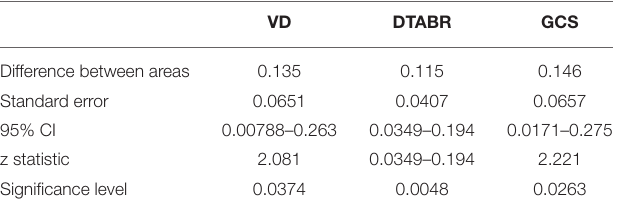
TABLE 3 | Pairwise comparison of the receiver-operating characteristic curve values. VD DTABR GCS Difference between areas 0.135 0.115